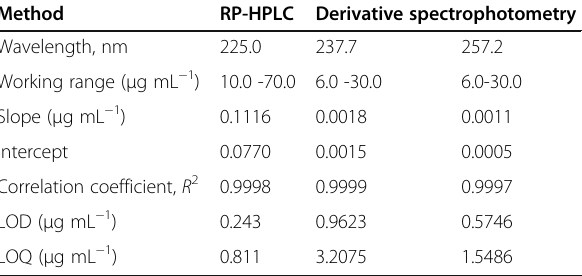
Table 5 Results of the application of proposed methods for Brintellix® tablets